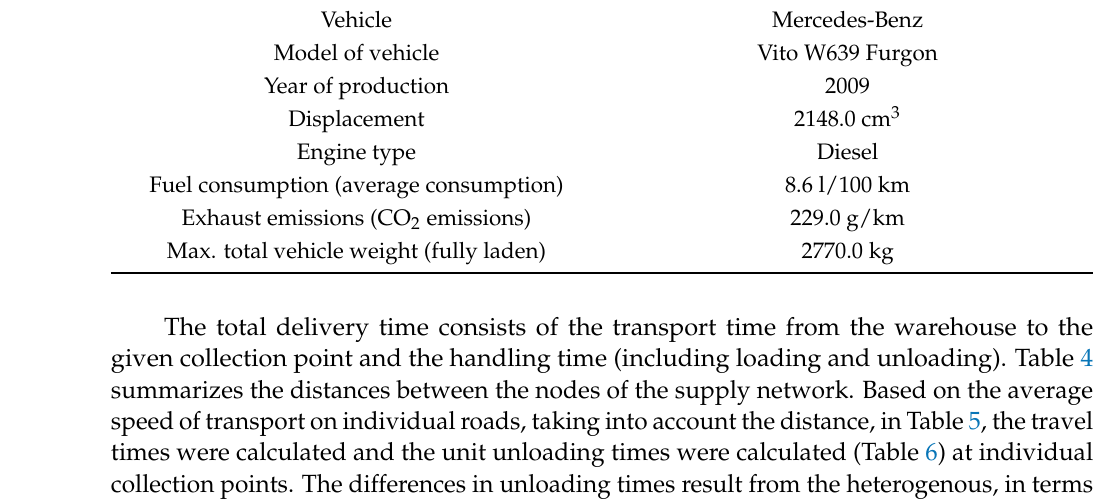
Table 3. Technical data of the transport means [68].